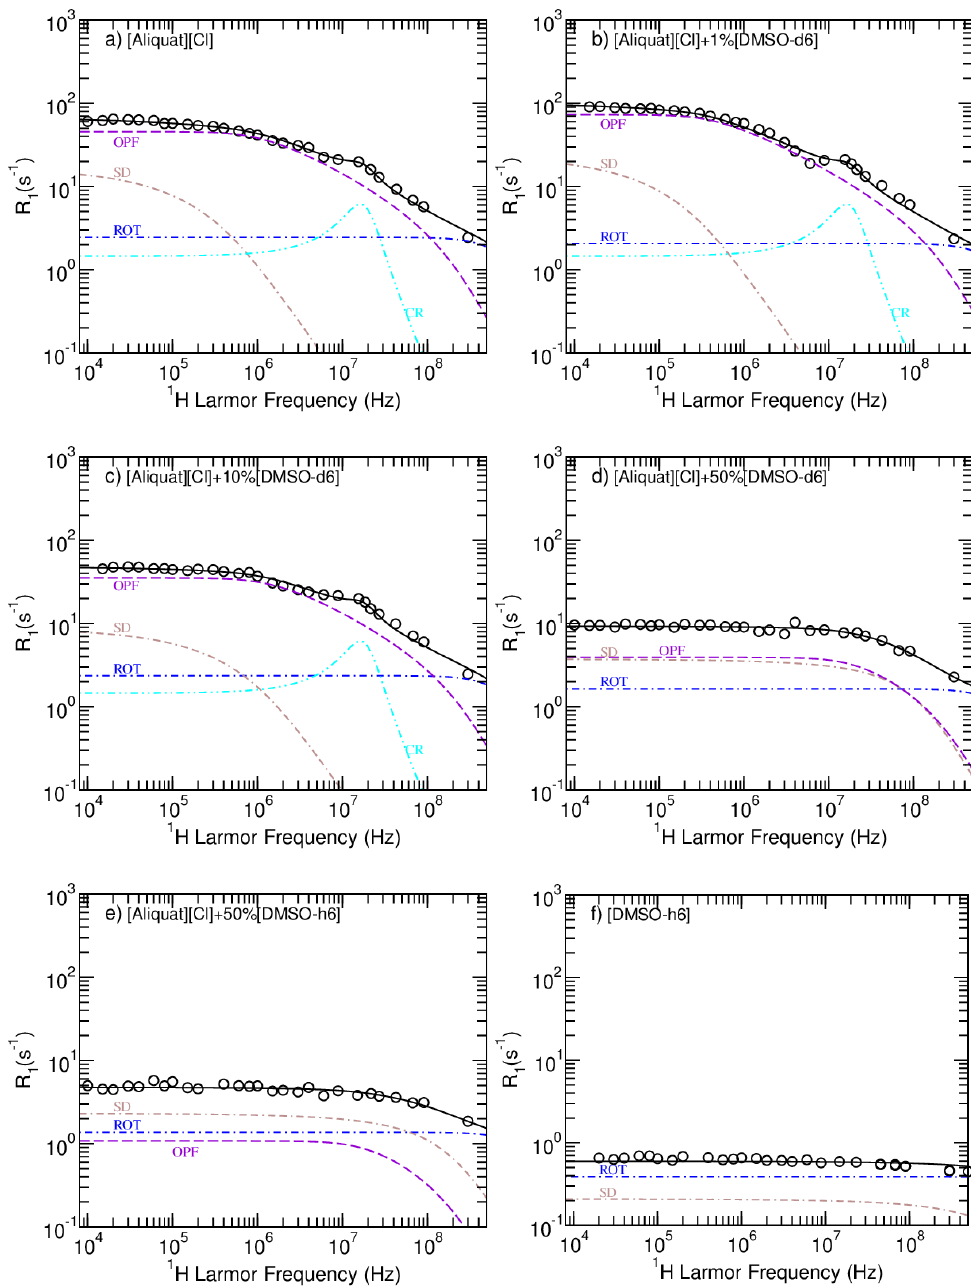
Figure 4. NMRD profiles obtained for the non-magnetic samples at 25 ◦ C. The solid black line is the sum of all relaxation contributions, the violet line corresponds to the OPF mechanism, the brown curve relates to relaxation due to self-diffusion, the blue line represents rotational diffusion contribu- tions and the cyan line describes cross-relaxation observed for the samples having between 0 and 10% ( v/v )